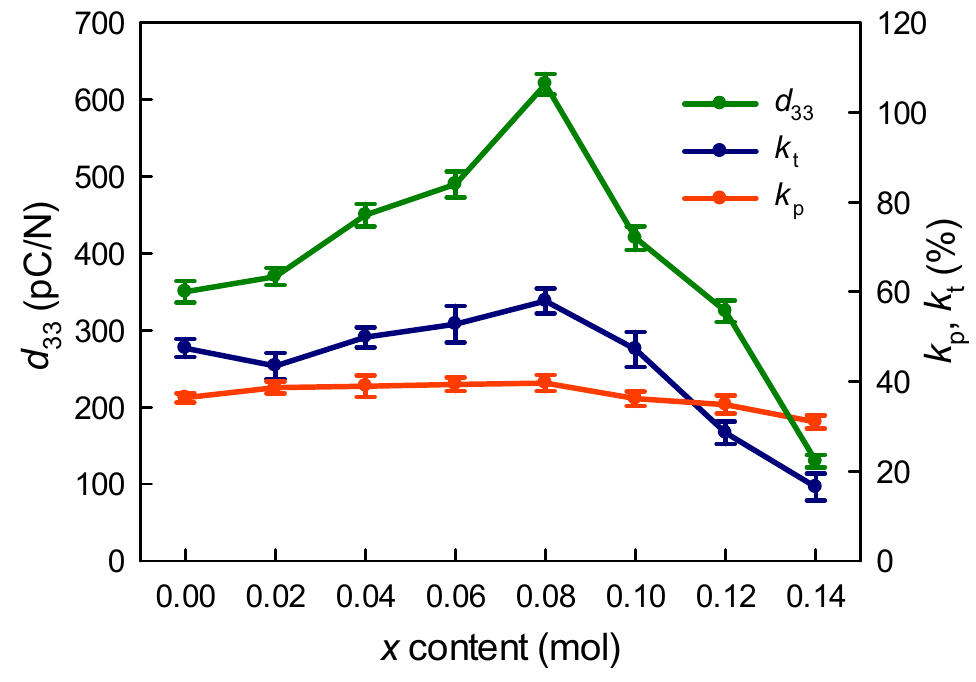
Figure 6. Composition-dependent piezoelectric constant d 33 , planar electromechanical coupling factor k p , and thickness electromechanical coupling factor k t of BT- x CS ceramics. Table 2. Ferroelectric and piezoelectric properties of BT- x CS ceramics.